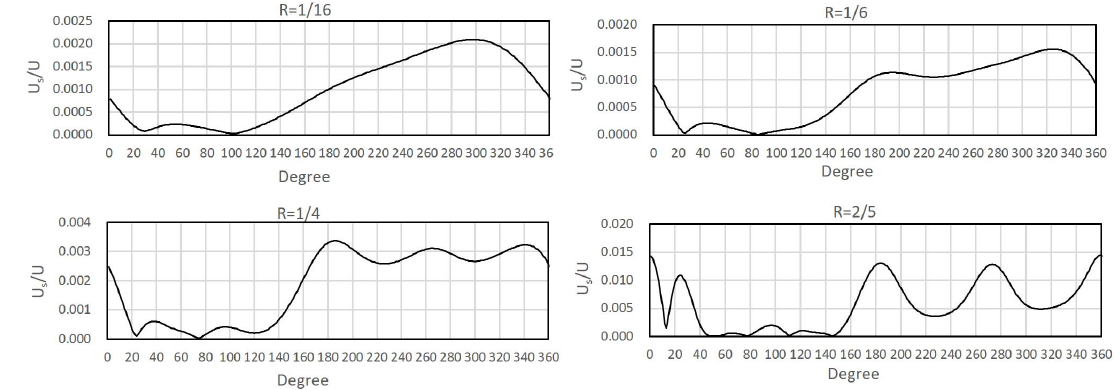
Figure 18. Flow speed around the obstacle for obstacle of various sizes at Re =